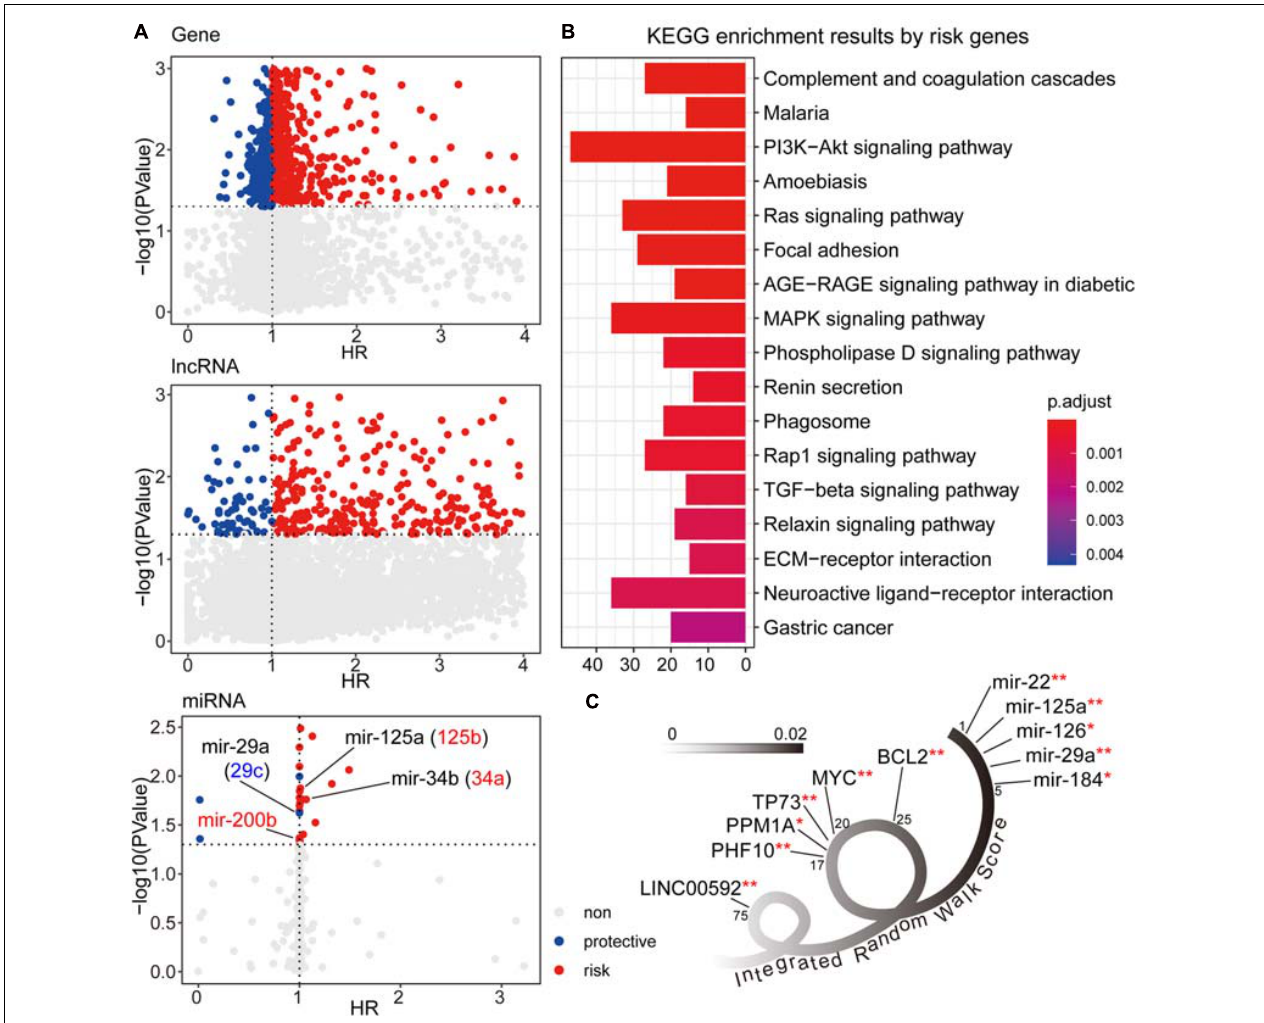
FIGURE 2 | (A) The univariate cox results for prognostic genes, lncRNAs, and miRNAs. (B) The KEGG enrichment analysis results for risk genes from univariate cox results. The corresponding enrichment results for protective genes were none. (C) The candidate signature results with decreasing IRW score. **symbol indicated the GC related markers, and *symbol indicated tumor related